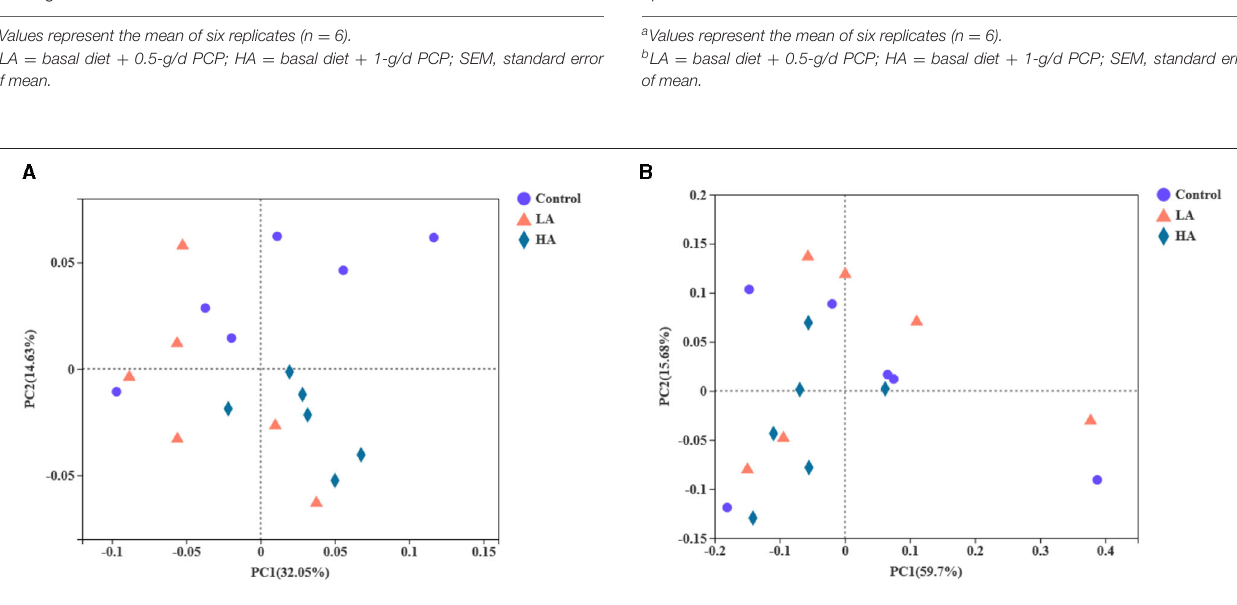
Frontiers in Veterinary Science |